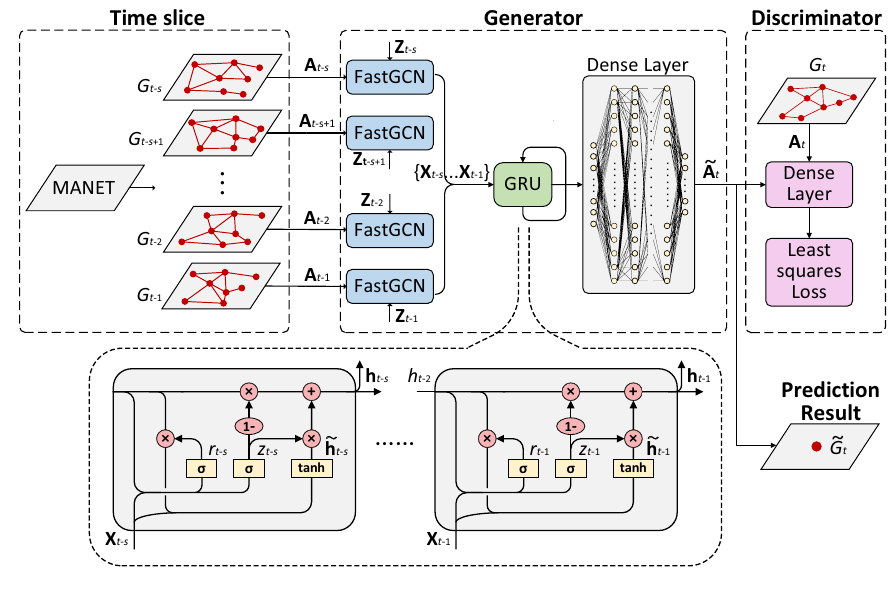
Figure 2. The framework of